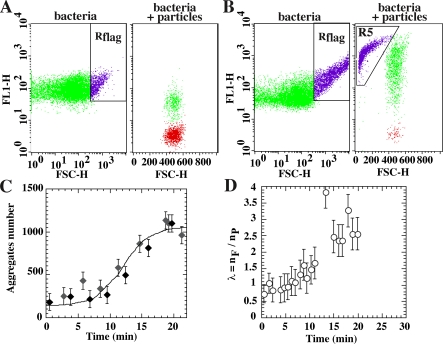
Self-Association of Free-Floating Cells and Cooperative Effects in Curli-Producing BacteriaBacteria (left) and colloid (right) dot plots of MG1655gfpompR234 brought into contact with NH3
+ particles before (A) and after (B) second colonization phase onset. (C) Number of events comprised in the Rflag gate in the presence (black diamond) or absence (gray diamond) of particles. Cells were taken from a culture (DO = 0.5) and resuspended by pipetting in an adequate volume of buffer at time t = 0. (D) Time dependence of cooperative index, λ, during MG1655gfpompR234 colonization.